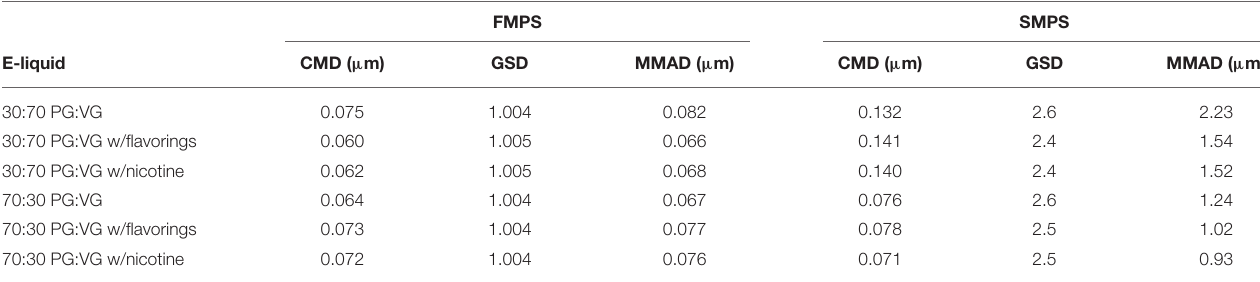
TABLE 2 | Number and calculated mass-based aerosol characteristics from fast mobility particle sizer (FMPS) and scanning mobility particle sizer (SMPS) measurements ( n = 6 trials/e-liquid). FMPS